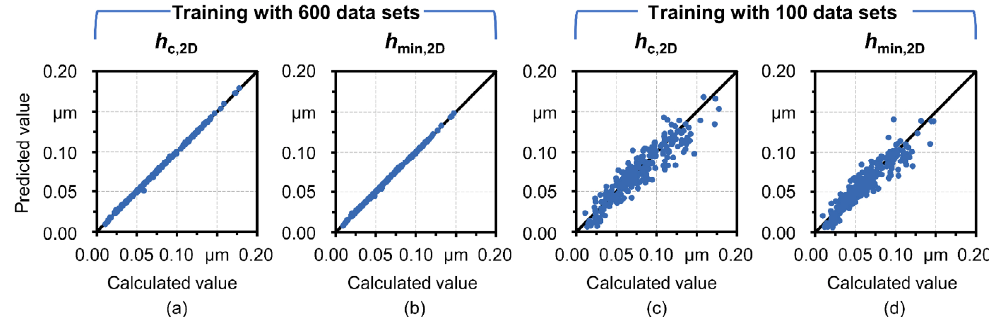
Fig. 9 Predicted versus calculated values of the central and minimum film thicknesses for the infinite 2D line contact using an ANN with 12 neurons in each of the two hidden layers after training with (a, b) 600 and (c, d) 100 data